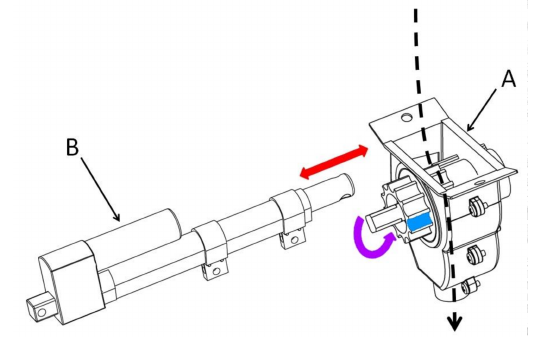
Figure 1. The proposed VRA dispenser with its components: ( A ) fluted roller box, and ( B ) electric actuator. The red arrow represents the linear movement performed in real time by B, while the purple arrow is the movement of the roller generated by the operation traction. The striped black arrow represents the trajectory of the fertilizer passing through the fluted roller box. Finally, the blue marked area indicates one of the grooves in the fluted roller where the fertilizer is caught (adapted from